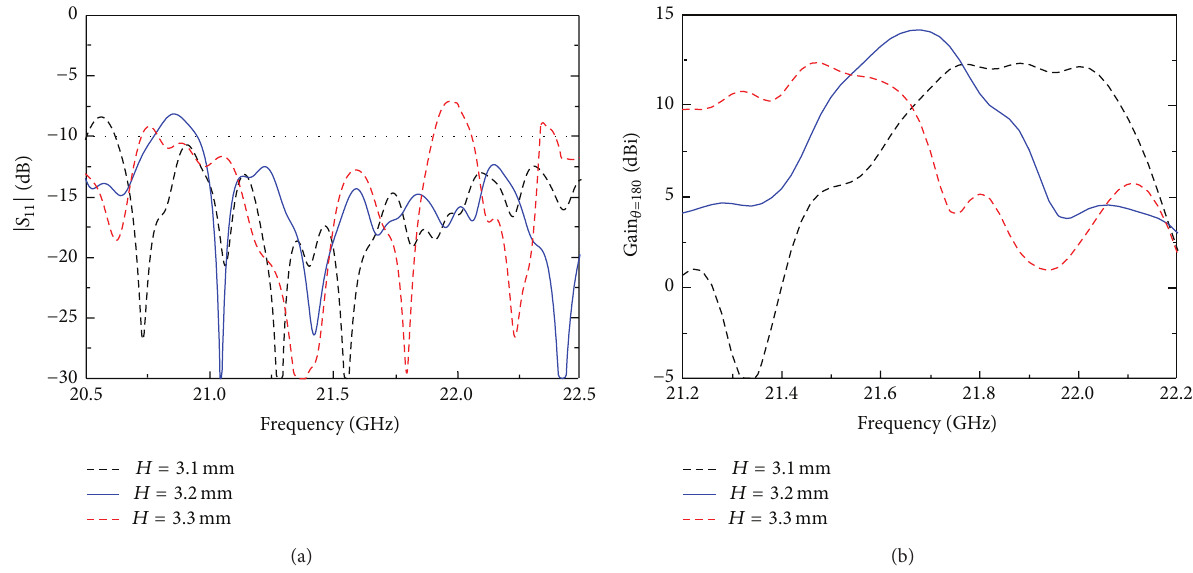
Figure 4: Effect of the cavity height, or substrate thickness, 𝐻 , on antenna characteristics with respect to (a) the reflection coefficient and (b) boresight gain.